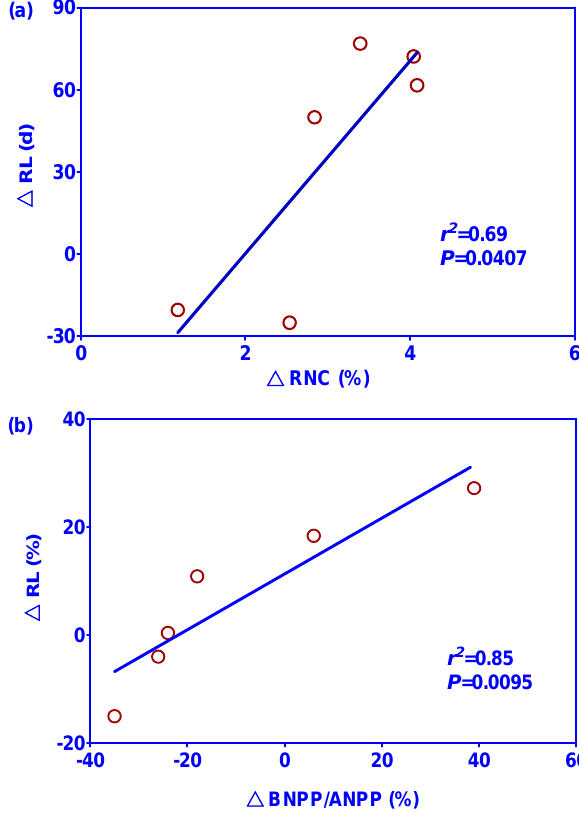
Fig. 6. Spatial dependence of day warming-induced changes in root longevity (RL) on day warming-induced changes in root nonstruc- tural carbohydrate content (RNC) (a) and BNPP/ANPP (b) across the 24 plots. Each data point represents the relative or absolute difference between the adjacent plots (ambient vs. elevated temper-